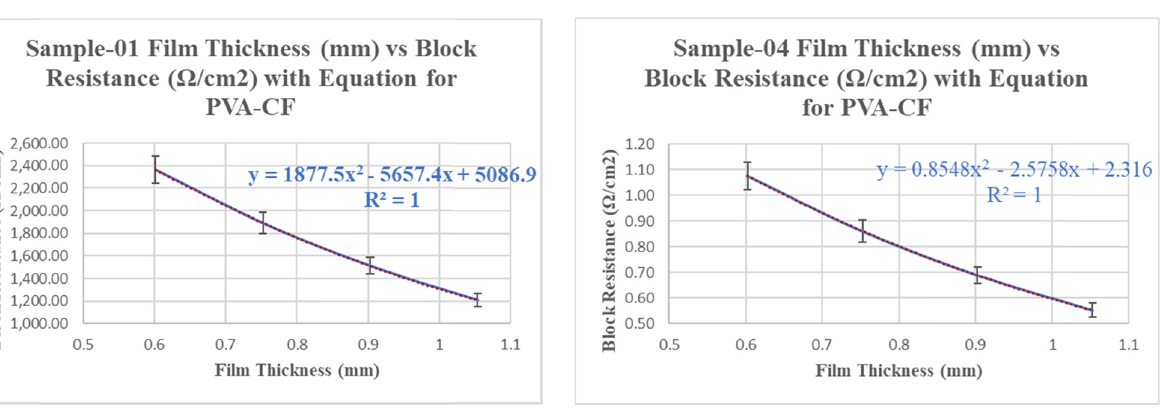
Figure 11: Sample - 01 ( CF:PVA = 0.1:30 ) block resistance ( Ω /cm 2 ) versus thickness ( mm ) with equation for PVA - CF. The dotted lines represent the polynomial fi tted curve and the linear fi tted curve.